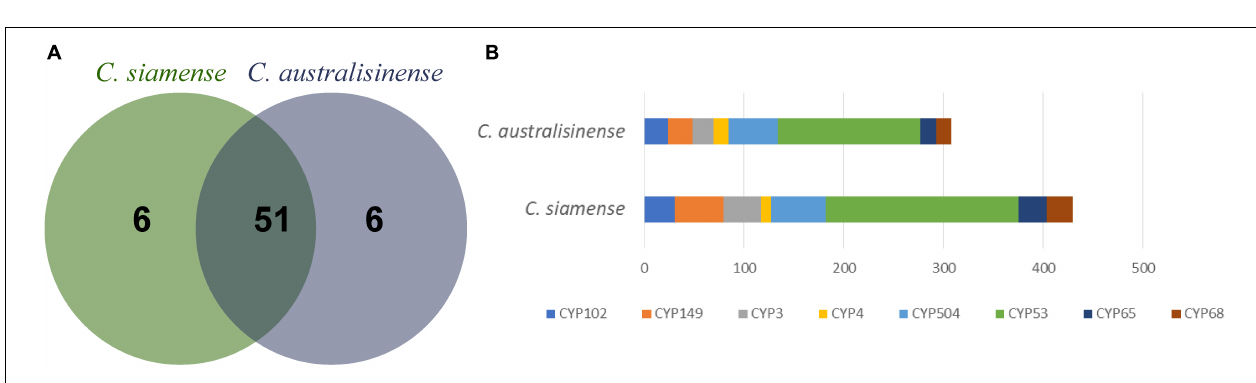
FIGURE 3 | Analysis of different CAZyme families in Colletotrichum siamense and C. australisinense . (A) Total number and category of CAZymes in the predicted secretome, GH, glycoside hydrolases; PL, polysaccharide lyases; CE, carbohydrate esterases; AA, auxiliary activities. (B) Comparative analysis of important fungal and plant cell wall degrading CAZyme families in the genomes of the two studied fungal species. Cs, C. siamense ; Ca, C. australisinense.